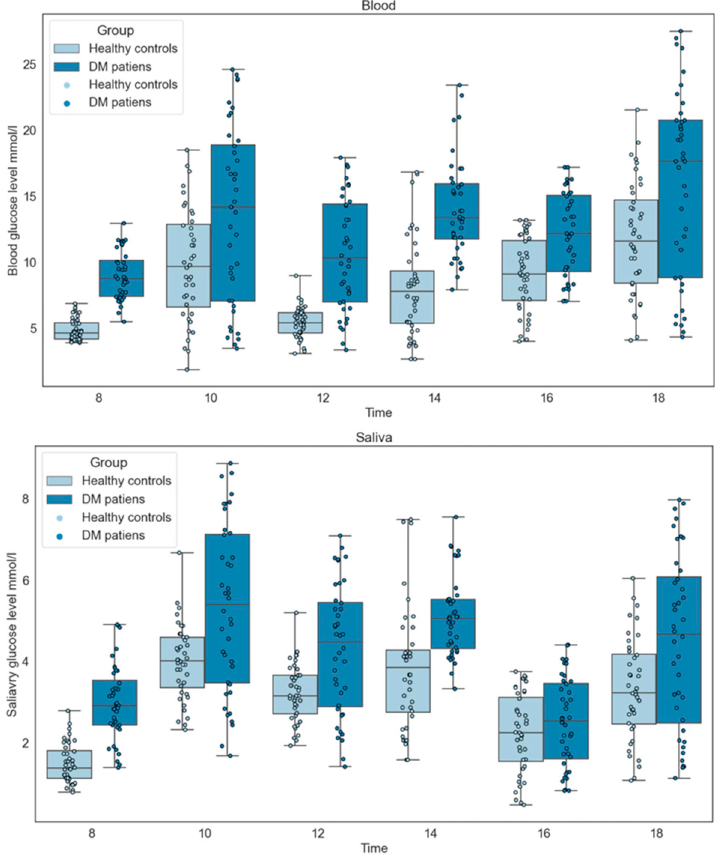
Figure 3. Comparison of saliva and blood glucose levels between DM patients and healthy